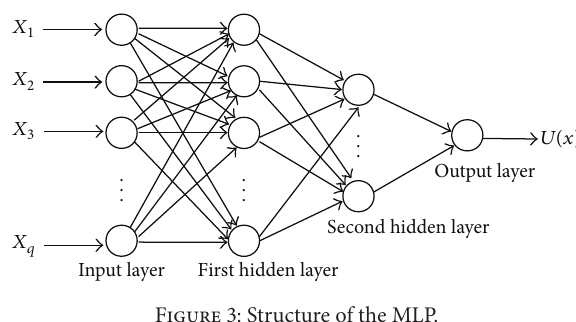
Figure 3: Structure of the